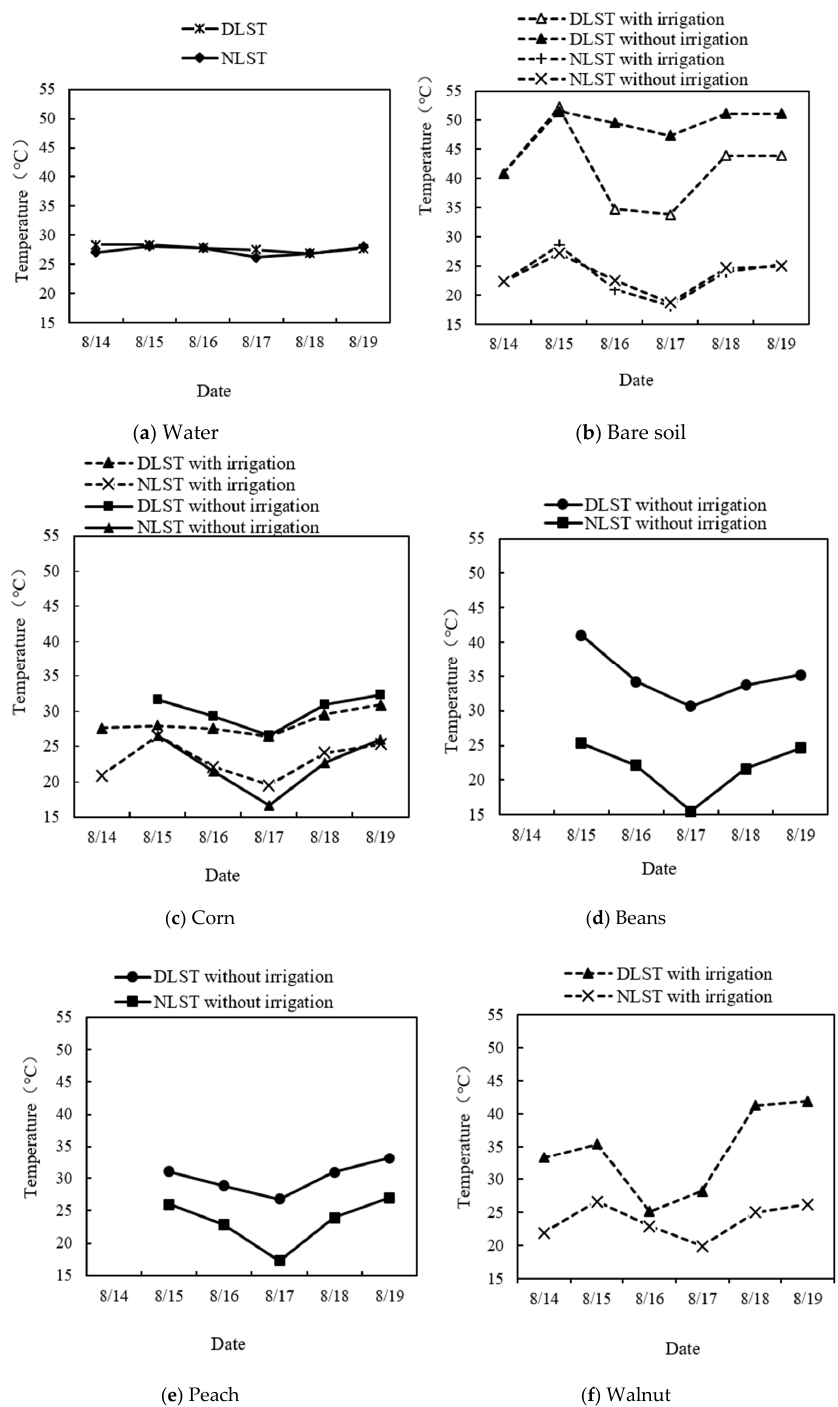
Figure 6. Daytime and nighttime LST monitoring results (DLST is short for daytime land surface temperature, NLST is short for nighttime land surface temperature). ( a ), ( b ), ( c ), ( d ), ( e ), and ( f ) are DLST and NLST monitoring results of water, bare soil, corn, beans, and peach respectively.